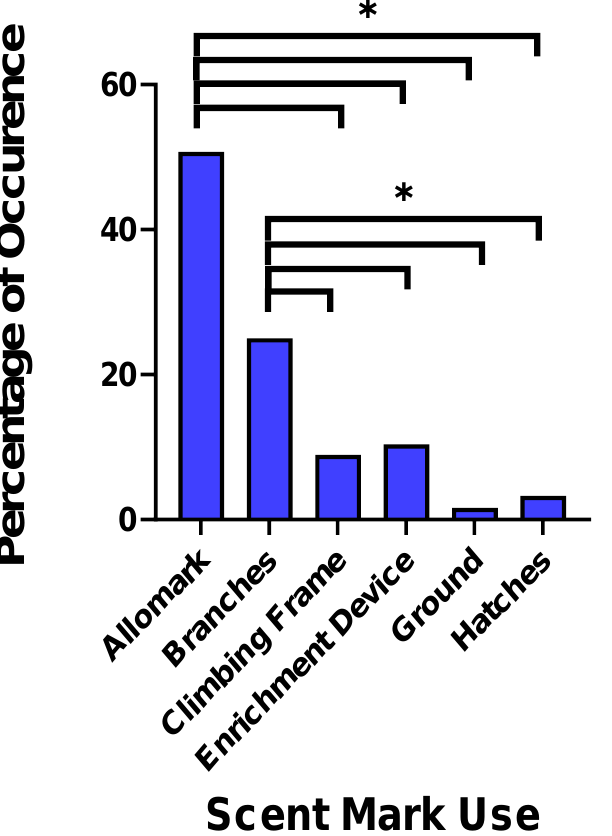
Figure 4. Percentages of occurrence for the use of male ano-genital marking. Allomarking accounted for the majority of ano-genital marking, followed by deposition on branches. A * indicates where significant differences between the scent-mark uses were found.